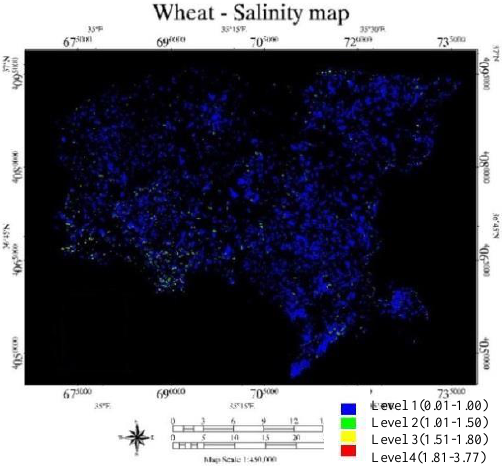
Figure 8. The map of the salt-affected wheat